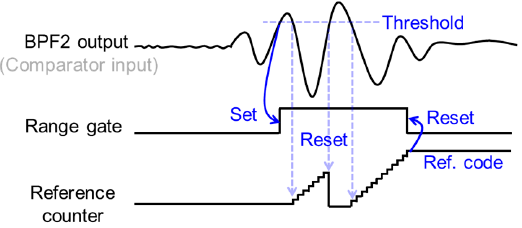
Figure 8. Hysteresis operation of comparator to generate the Range gate signal.